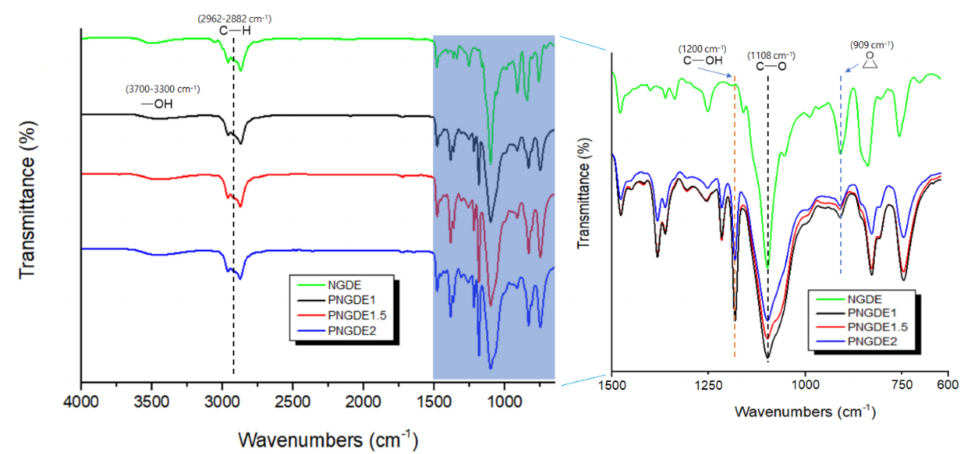
Figure 1. FT-IR spectra of NGDE monomer and PNGDE 1, PNGDE 1.5, and PNGDE 2 with enlarged scale of 1500–600 cm − 1